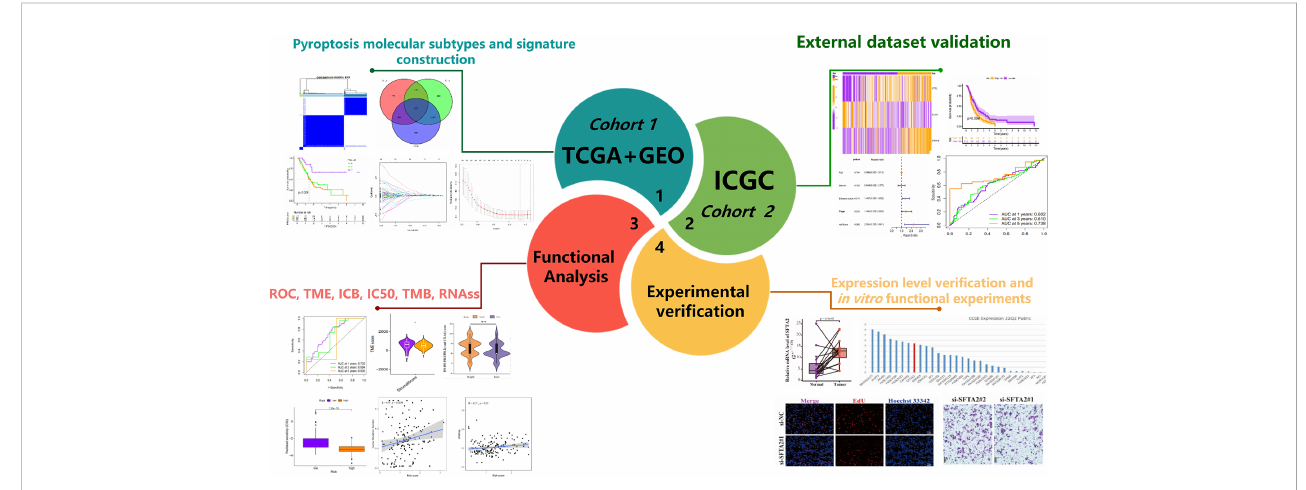
FIGURE 1 Rough fl ow chart of this